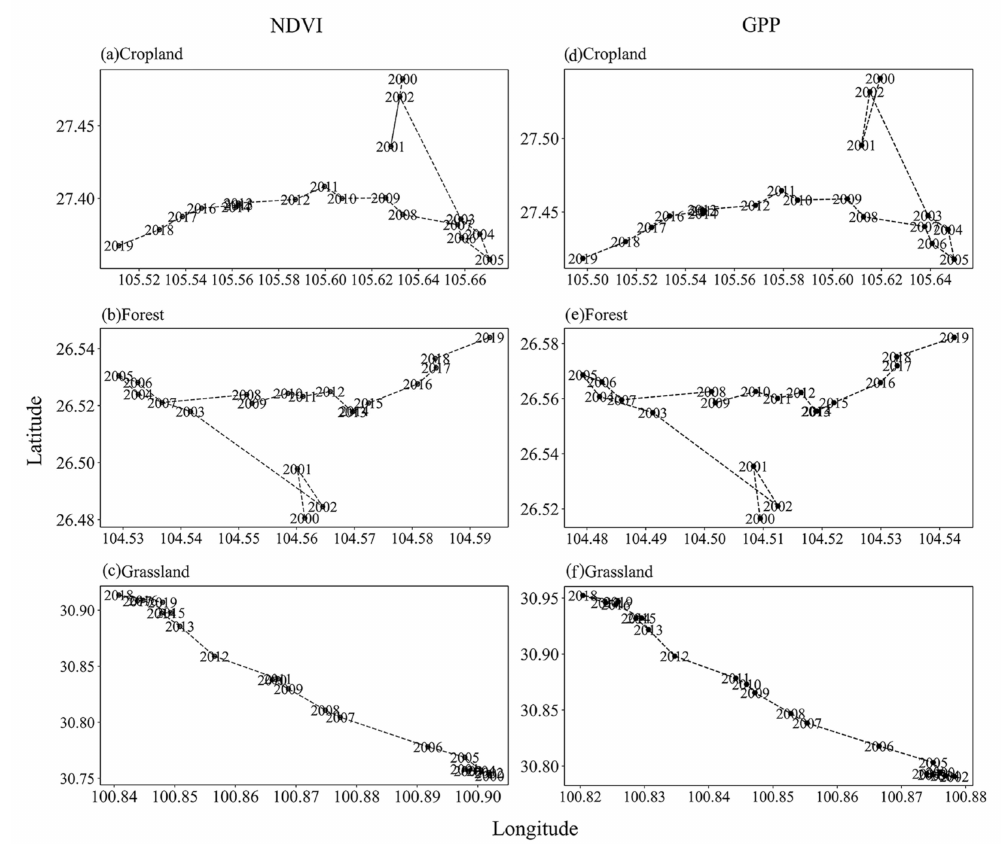
Figure 5. Changes in the center of gravity of NDVI and GPP. (Note: ( a – c ): Changes in the NDVI center of gravity of cropland, forest and grassland from 2000 to 2019; ( d – f ) Change in the GPP center of gravity of cropland, forest and grassland from 2000 to